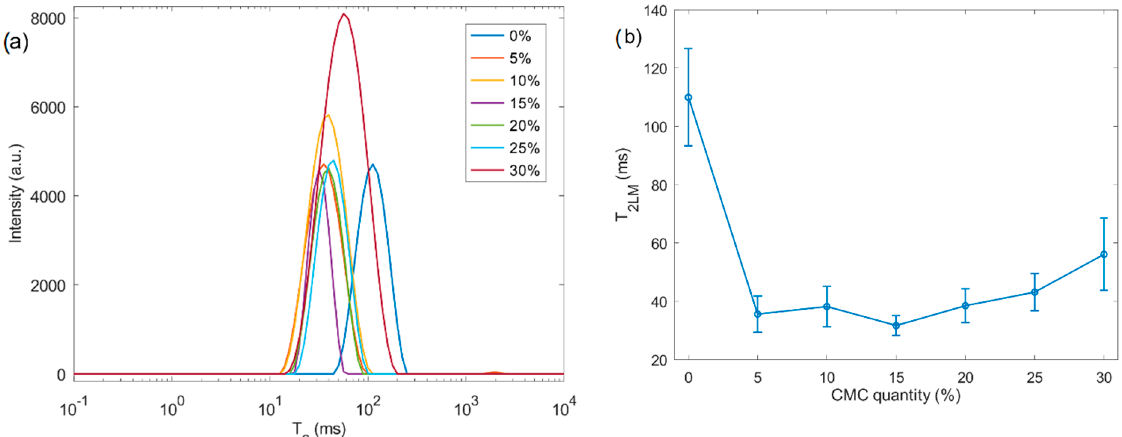
Figure 3. 1 H NMR transverse relaxation results. ( a ) T 2 distributions of cellulose-based samples. values for the pristine cellulose (sample Cel0); the T 2 was shortened with the addition of various percentages of CMC (shown in the legend). ( b ) Log-mean of T 2 distributions showing a sudden shortening in value (5% w / w CMC), followed by an incremental transition towards higher values with increasing the amount of CMC. Error bars indicate the width of the distribution.